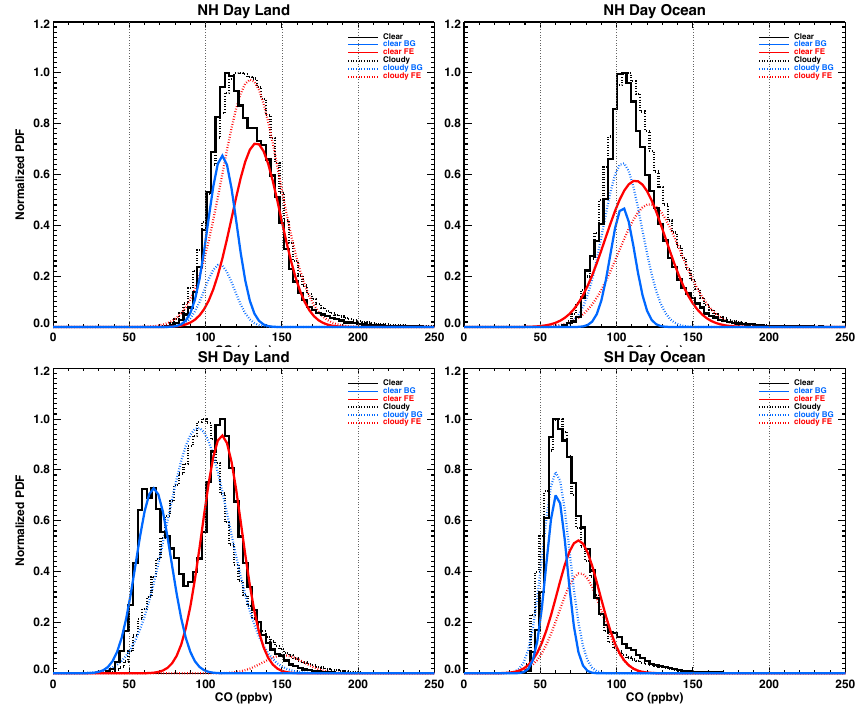
Figure 6. The monthly mean CO VMRs for March to May, 2006, using PDFs for the NH land (upper left panel), NH ocean (upper right panel), SH land (lower left panel), and SH ocean (lower right panel), for daytime only.